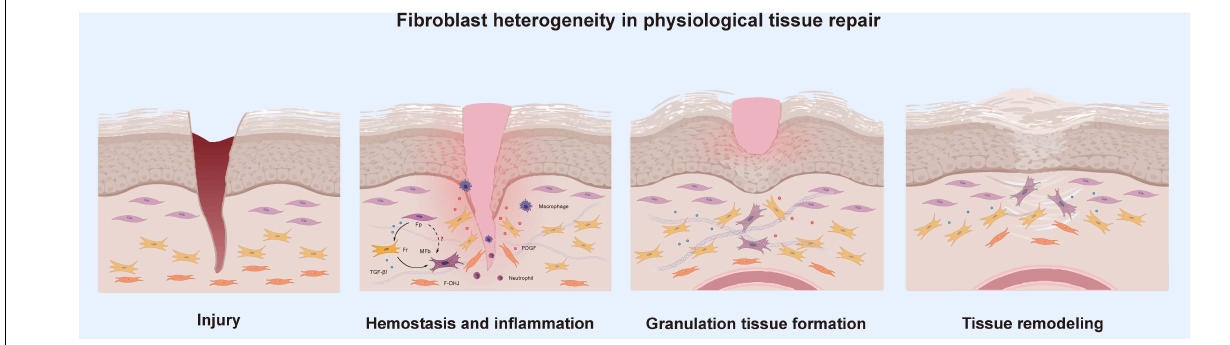
FIGURE 2 | Fibroblast heterogeneity in physiological tissue repair.